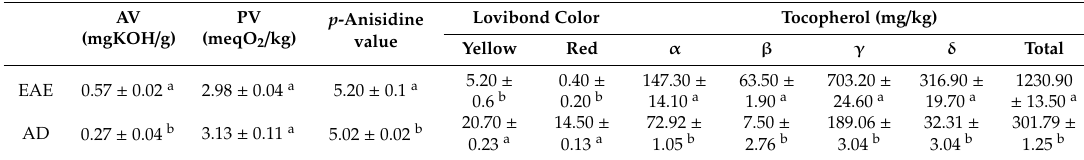
Table 1. Properties of soybean oil prepared by enzyme-assisted aqueous extraction (EAE) and conventional alkaline deacidification (AD).